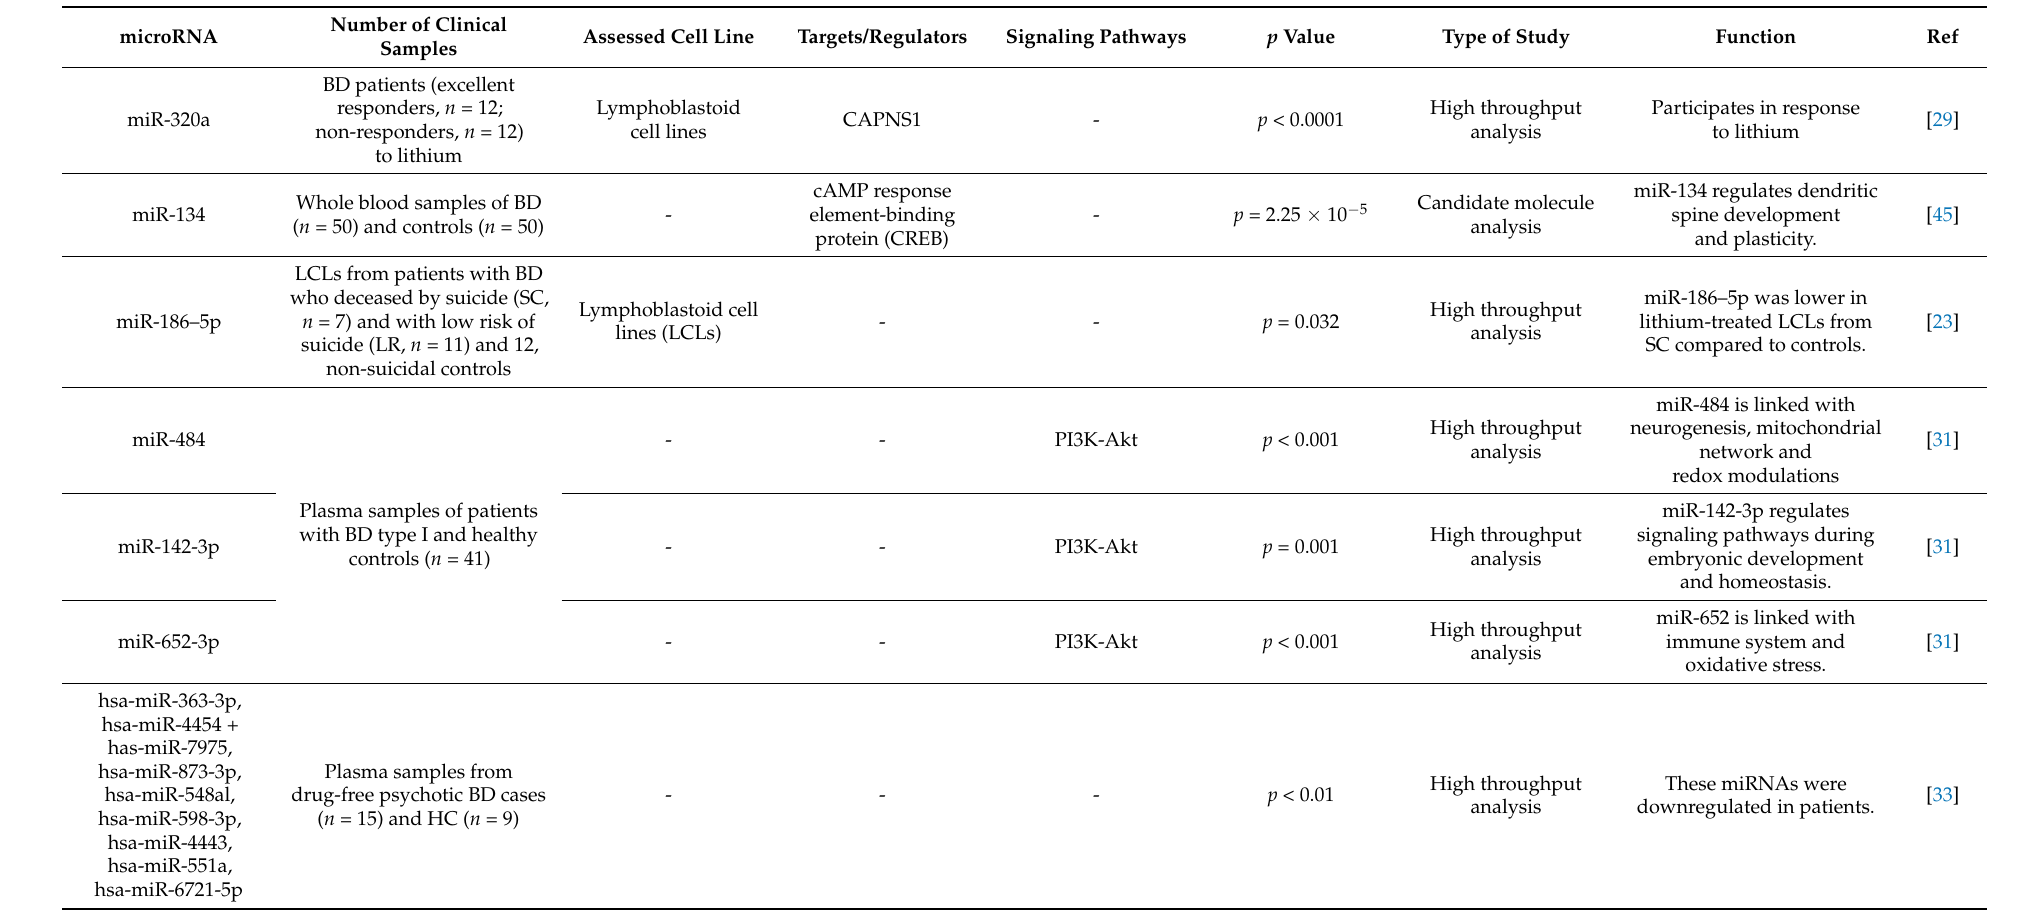
Table 6. Summary of function of down-regulated miRNAs in BD (BP: bipolar disorder, SZ: